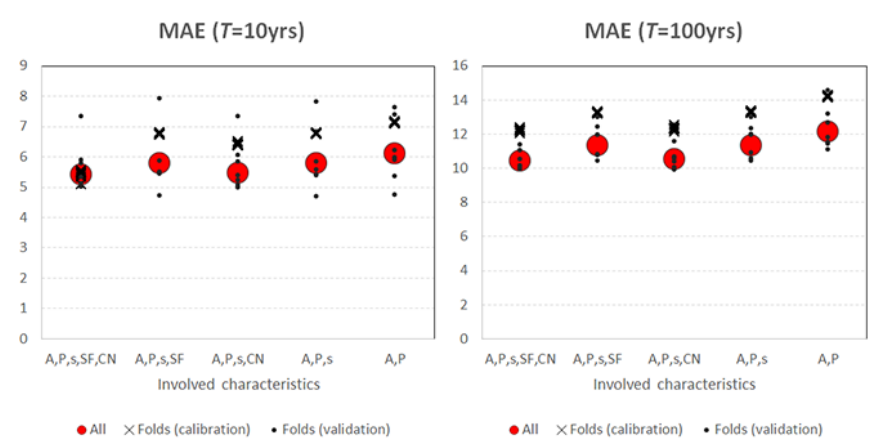
Figure 18. Values of mean absolute error (m 3 s − 1 ) for calibration to the whole data set and for calibration and validation using 7 folds for T = 10 years (left panel) and T = 100 years (right panel).